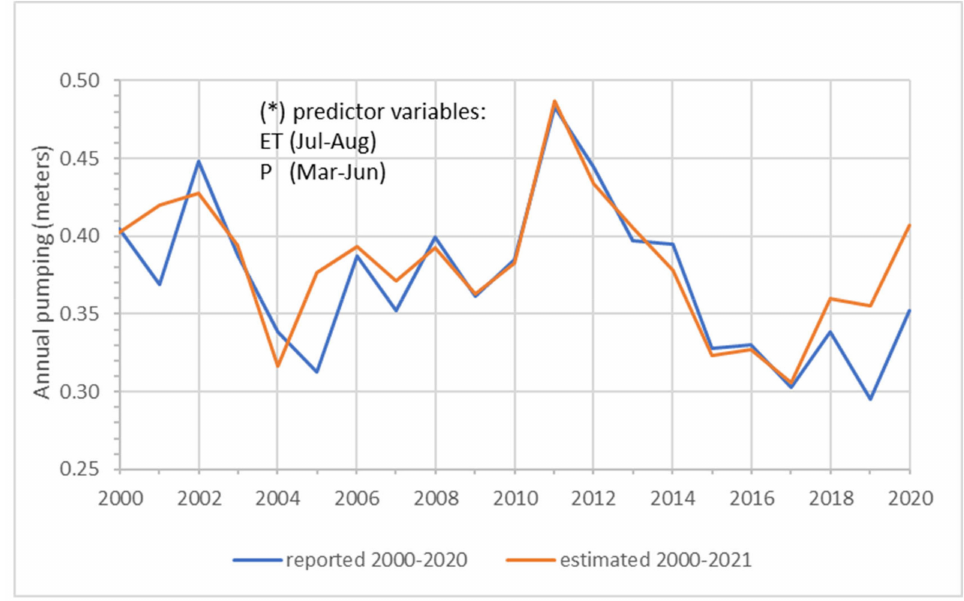
Figure A4. GMD 3 reported and estimated * pumping 2000–2020 using a regression based on 2006–2017